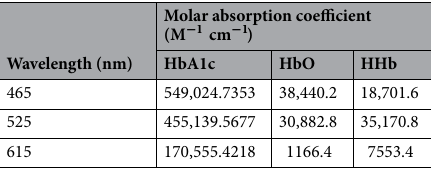
Table 1. Molar absorption coefficient of HbA1c, HbO, and HHb for the respective wavelengths.